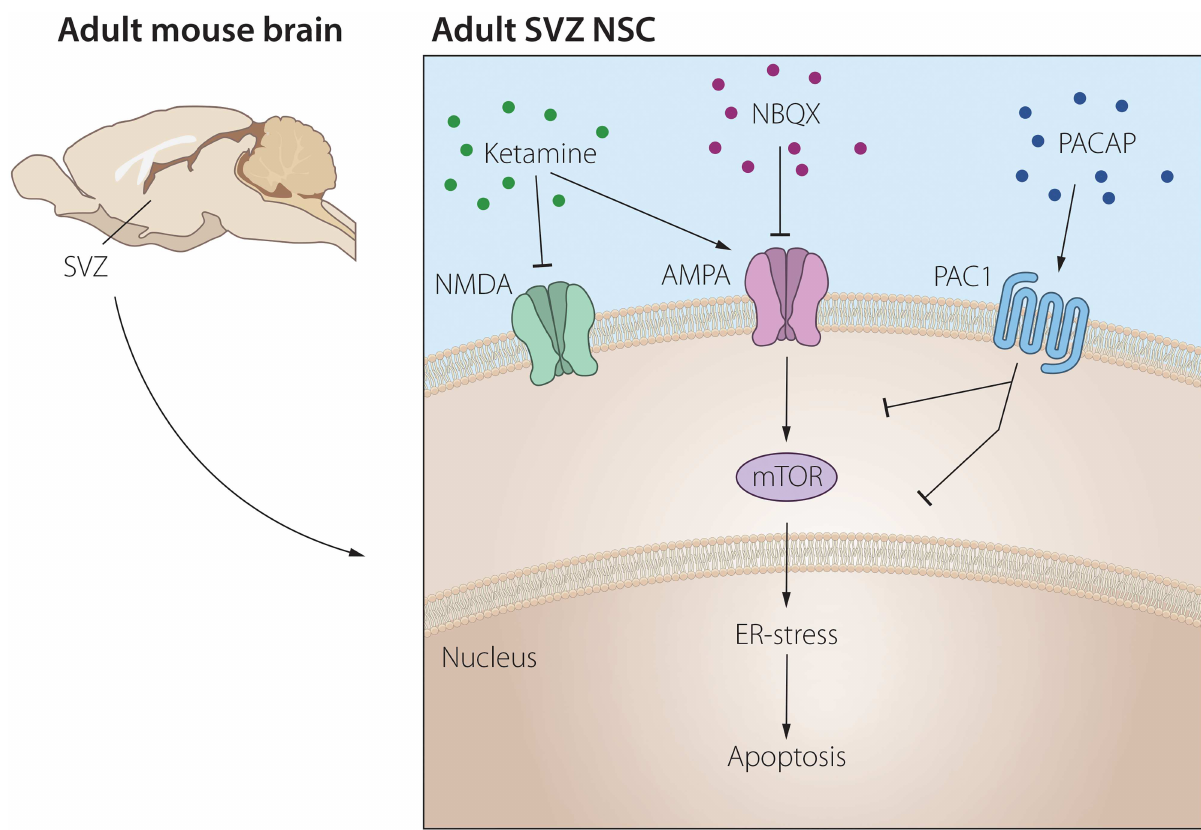
Fig 6. A schematic diagram showing a proposed signaling pathway for PACAP mediated suppression of ketamine induced neurotoxicity of NSCs in vitro